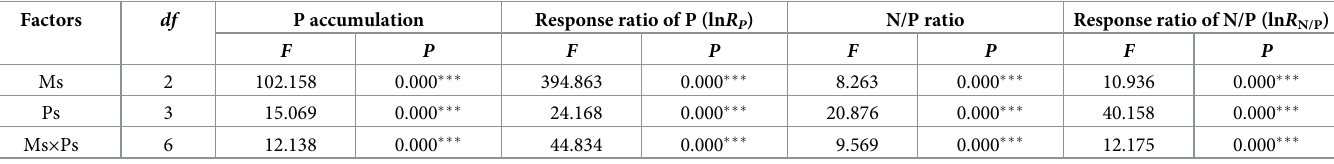
Abbreviations: Ms = Soil microbial condition treatments; Ps = Plant species; � or �� or ��� indicates a significant difference in P < 0.05 or P < 0.01 or P <